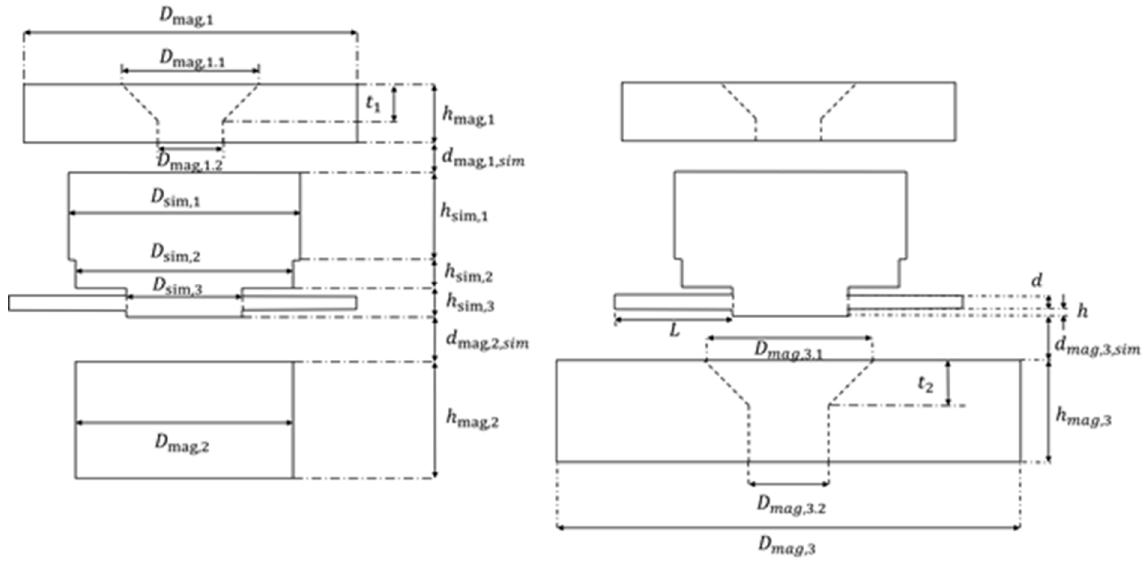
Figure A2. 3D geometry of the magnet-SPION configurations.